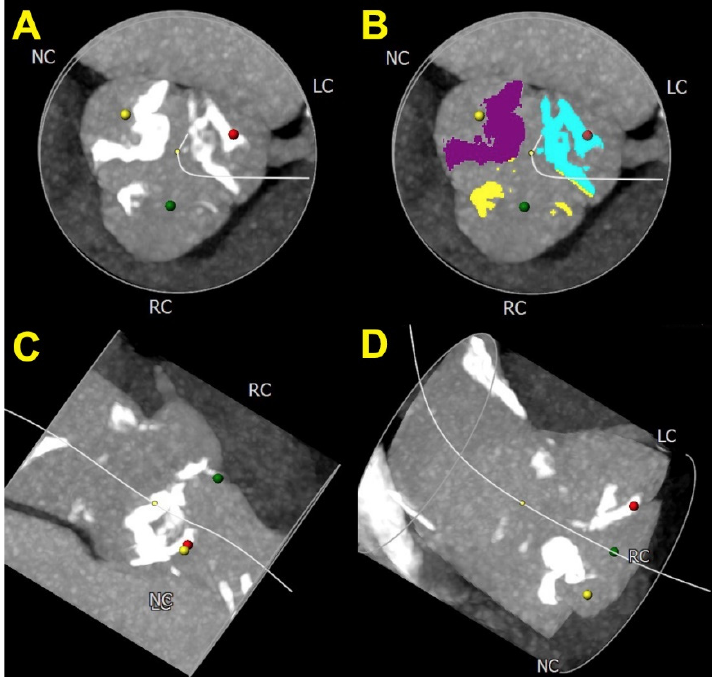
Figure 3. Computed tomography preparation for TAVI depicting very calcified aortic valve in different projections. LC—left coronary cusp, NC—non-coronary cusp, RC—right coronary cusp, ( A ) calcifications on each cusp of the aortic valve, ( B ) calcification depicted in different colors to facilitate the calculation of aortic valve calcification score, ( C ) aortic valve at the particular position provides better visualization for TAVI (RAO 99°, caudal 51°), ( D ) aortic valve at the particular position to provide better visualization for TAVI (RAO 7°, caudal 1°).